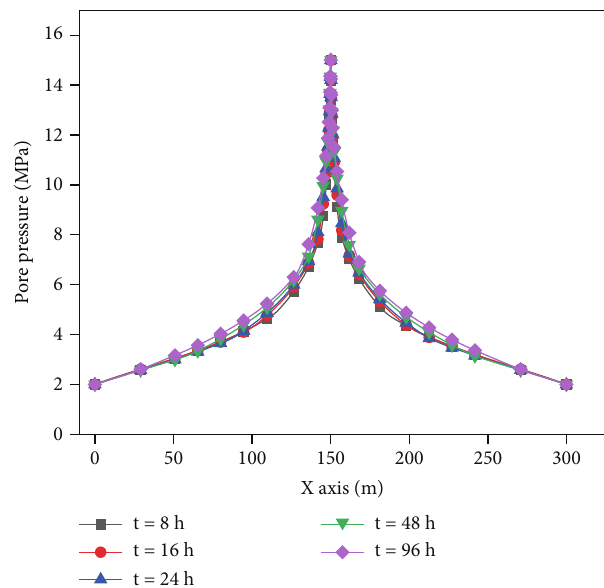
Figure 24: Pore pressures under water-air alternating displacement along line